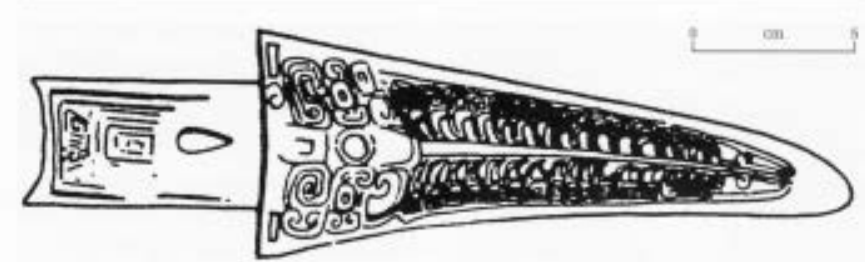
Figure 4 A bronze blade (ge) from the burial site at Mianzhu, Chengdu Plain. The styl­ ized motifs imitate patterns used on weapons produced during the Western Zhou dynasty (1050-771 BC) in the present province of Henan. (After Wenwu